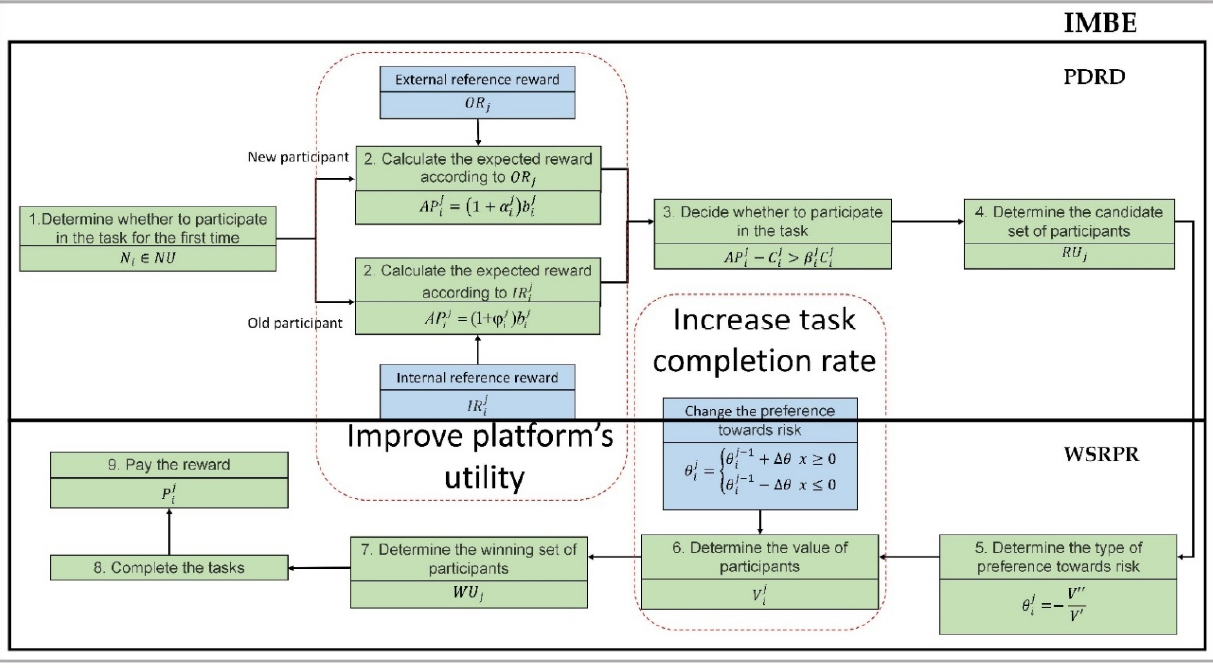
Figure 3. Logic model of IMBE.